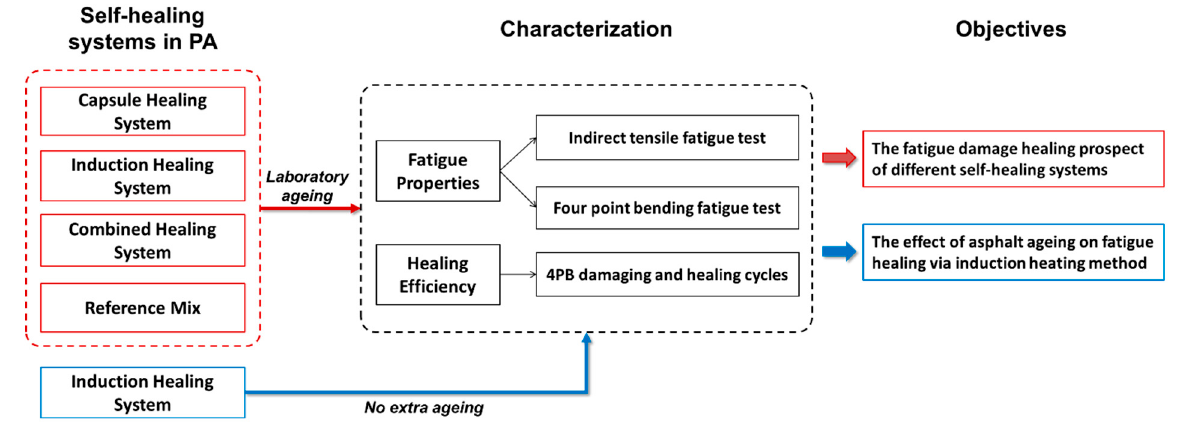
Figure 3. The research methodology of this study.